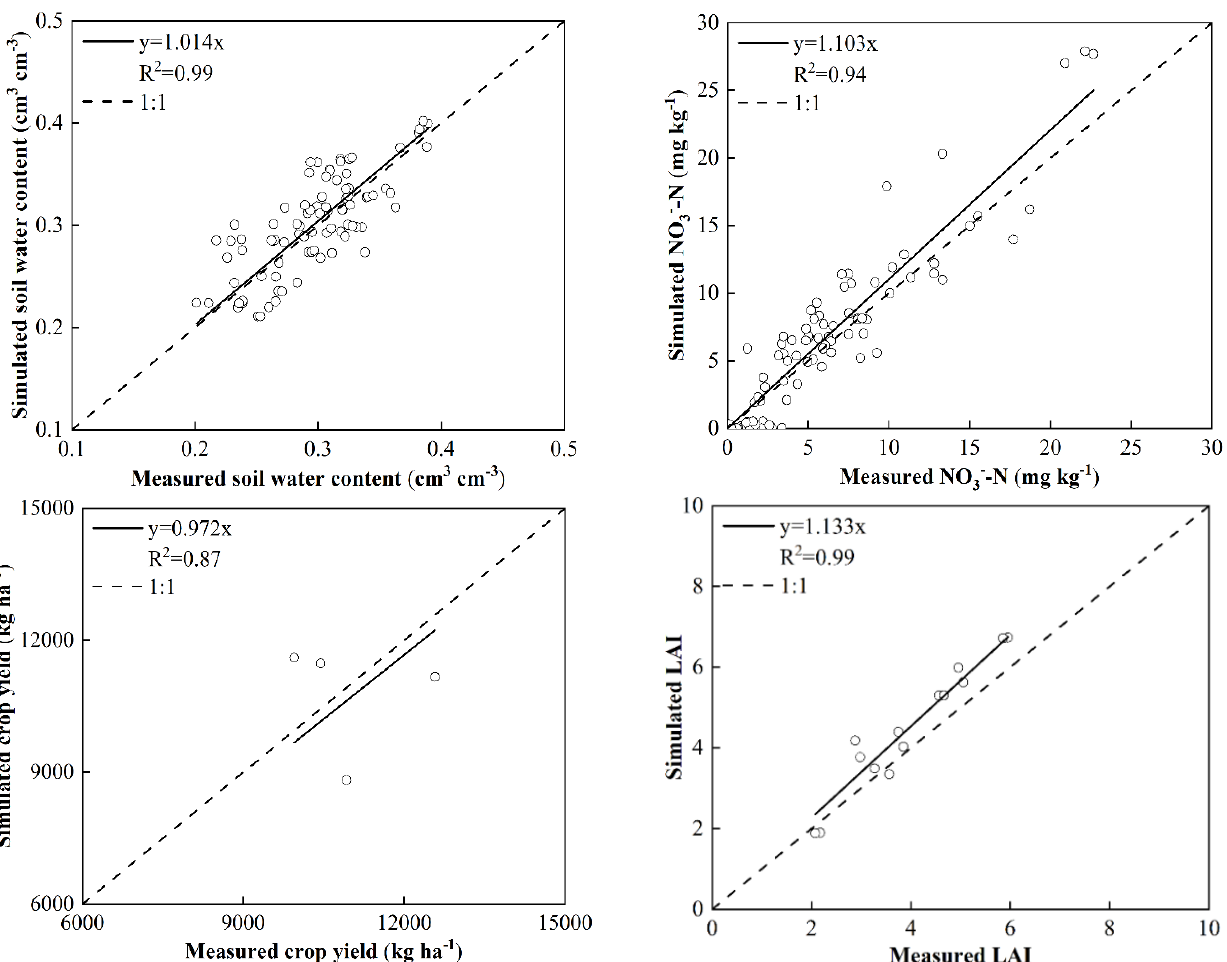
Figure 5. The relationship between measured and simulated soil water contents, nitrate concentra- tions, crop yields, and LAI under the validation treatments in loamy clay soil.